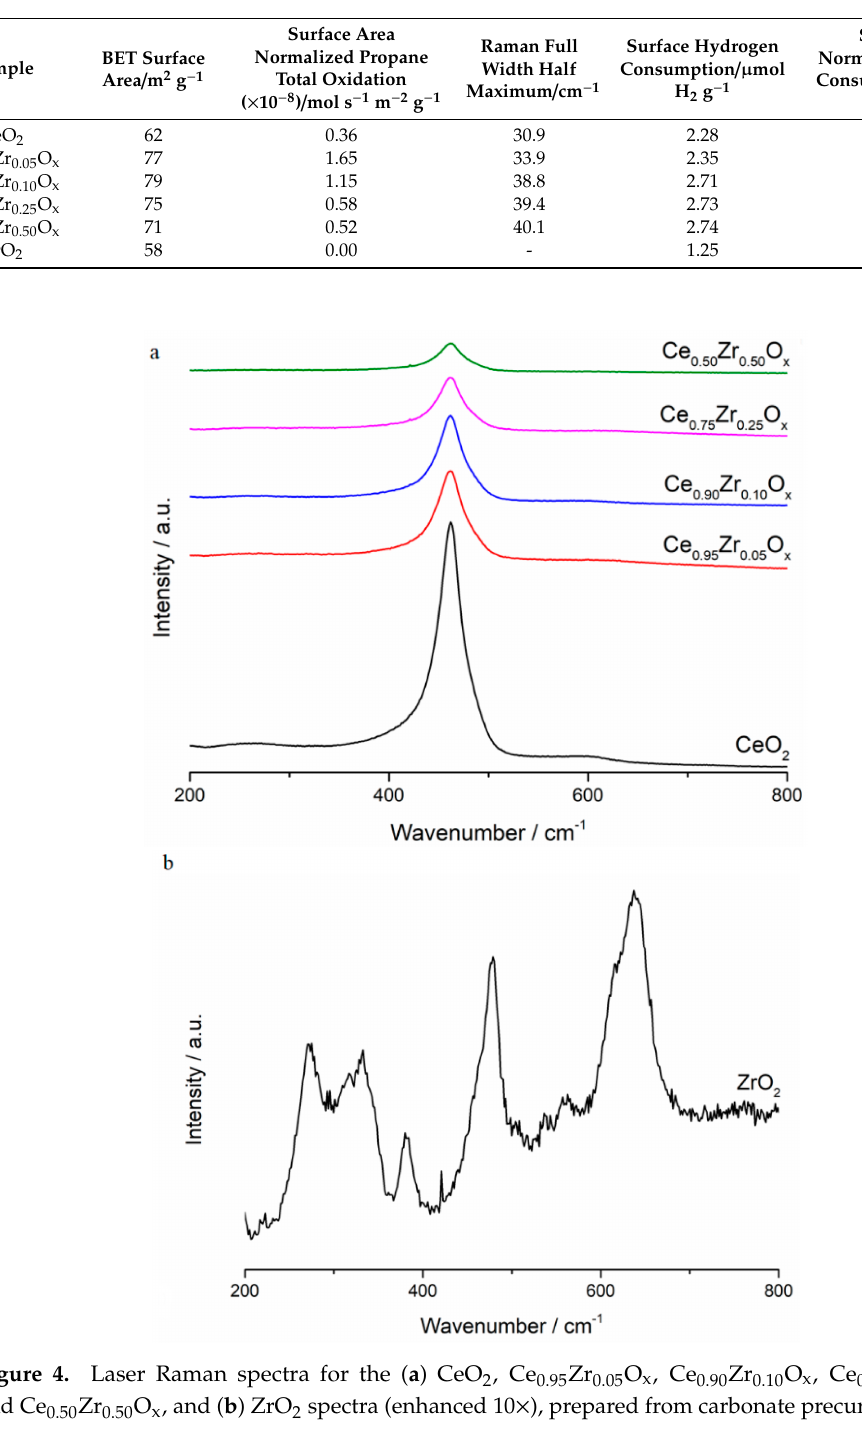
Table 2. Physiochemical properties of the range of ceria–zirconia catalysts.